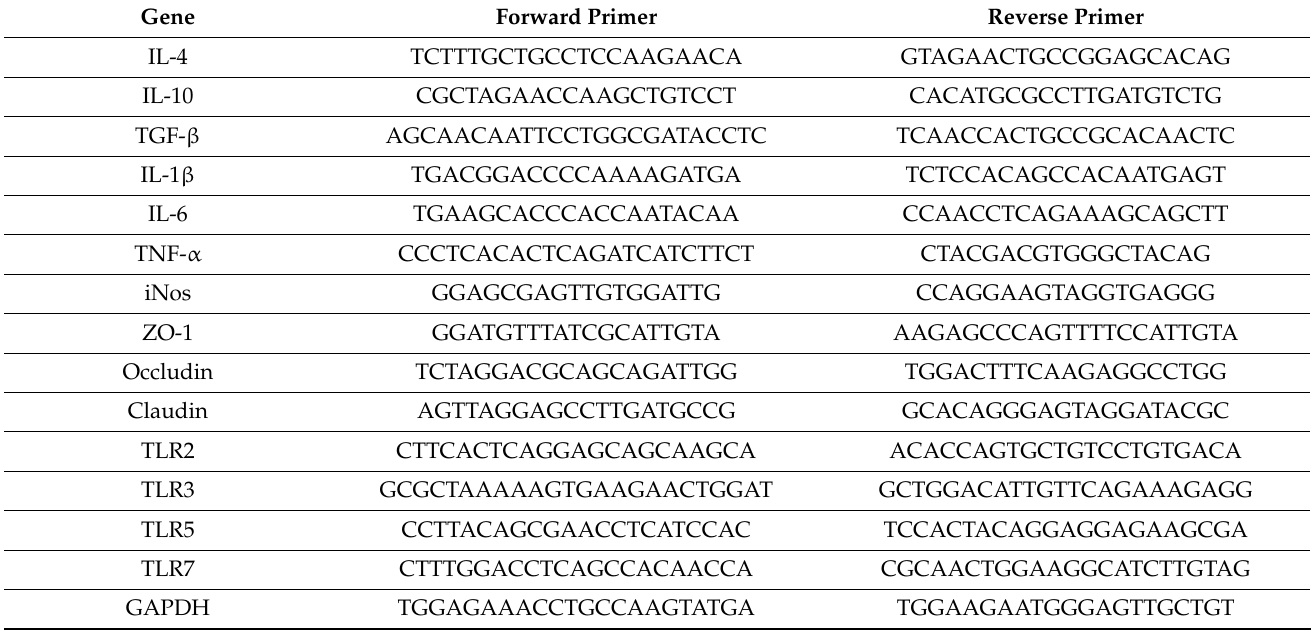
Table 1. Primers of